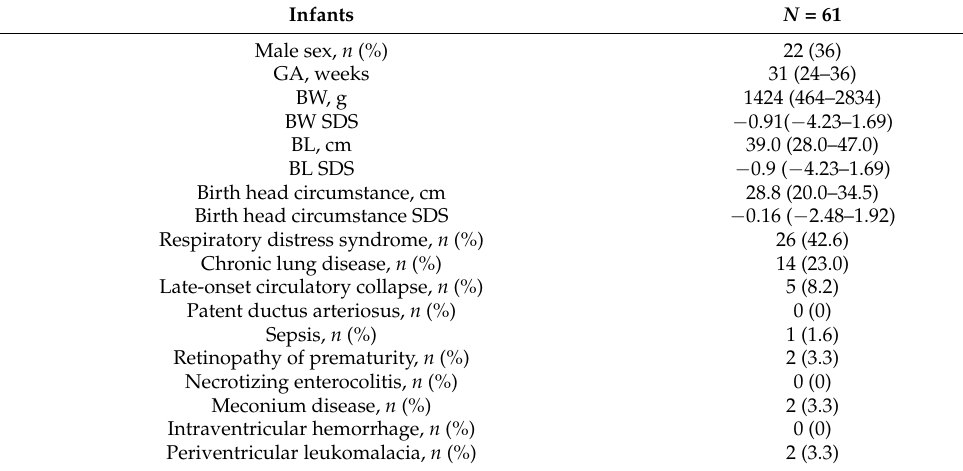
Figure 1. Gestational age at birth and plasma cortisol levels at birth or at 1 month of age. Red rhombus: small-for-gestational age (SGA), Blue circle: non-SGA. 3.1.3. Association between Plasma Cortisol Levels and GA, and Anthropometric Values at Birth